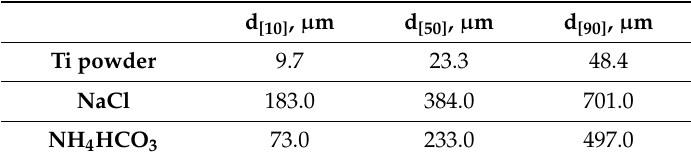
Table 1. Particle size distribution of materials